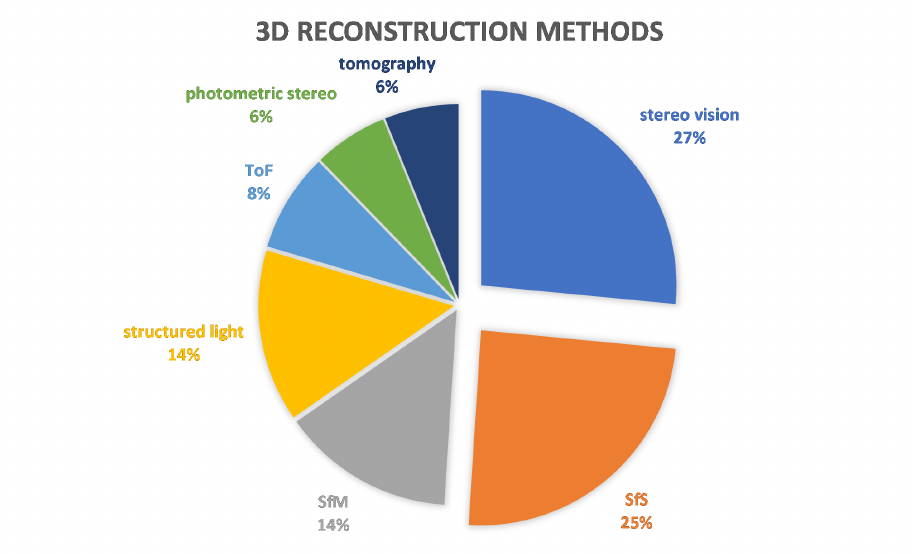
Figure 10. Three-Dimensional (3D) Reconstruction